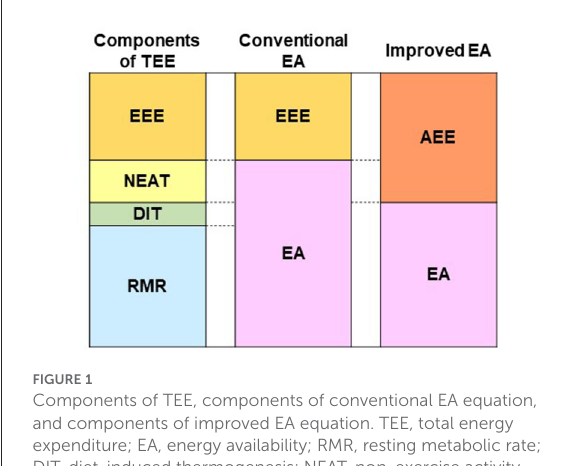
FIGURE1 Components of TEE, components of conventional EA equation, and components of improved EA equation. TEE, total energy expenditure; EA, energy availability; RMR, resting metabolic rate; DIT, diet-induced thermogenesis; NEAT, non-exercise activity thermogenesis; EEE, exercise energy expenditure; AEE, activity-induced energy expenditure. Conventional EA (kcal/kg FFM/day) = [EI (kcal/day) – EEE (kcal/day)] / FFM (kg). Improved EA (kcal/kg FFM/day) = [EI (kcal/day) – AEE (kcal/day)] / FFM